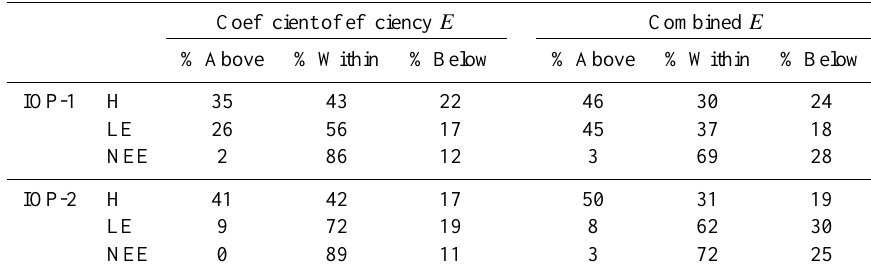
Table 5. Percentage of observations above, within and below the 5th and 95th quantile predictive uncertainty bounds for the single-objective coefficient of efficiency (left) and the combined coefficient of efficiency (right) for the sensible (H) and latent heat flux (LE) and the net ecosystem exchange (NEE) for IOP-1 and